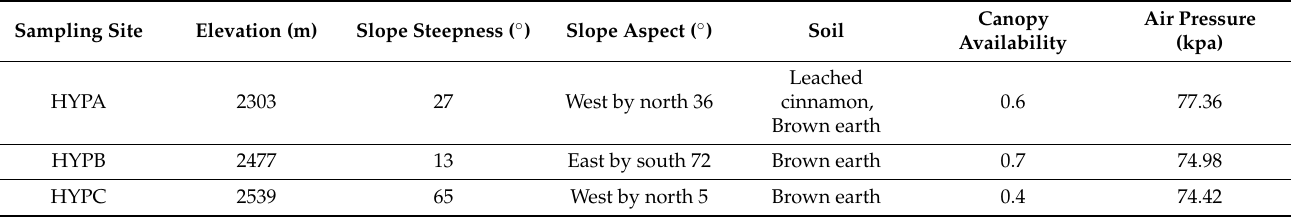
Table 2. Information about the sampling sites of L . principis-rupprechtii .